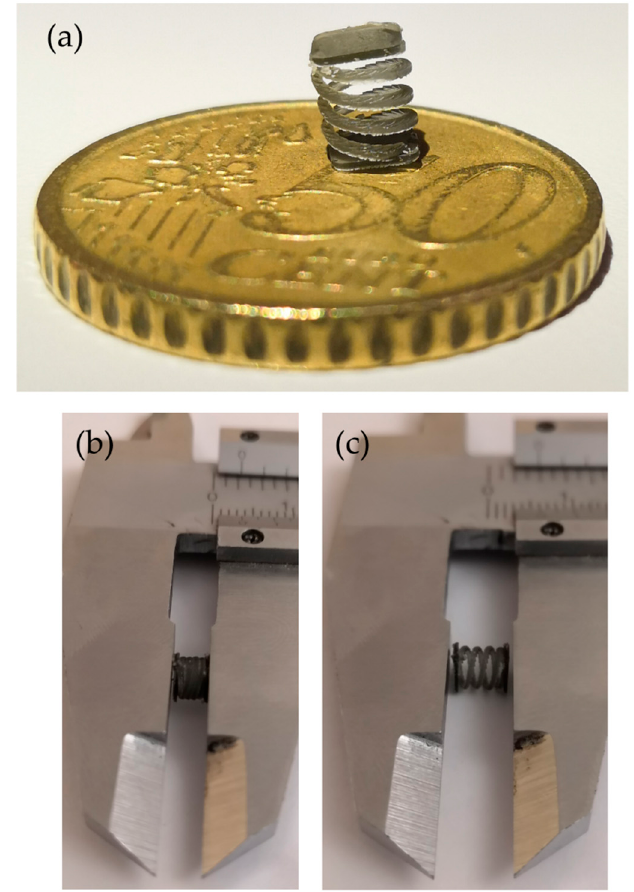
Figure 7. SL printed micrometric spring. ( a ) Geometry details, ( b ) compression, ( c ) release.